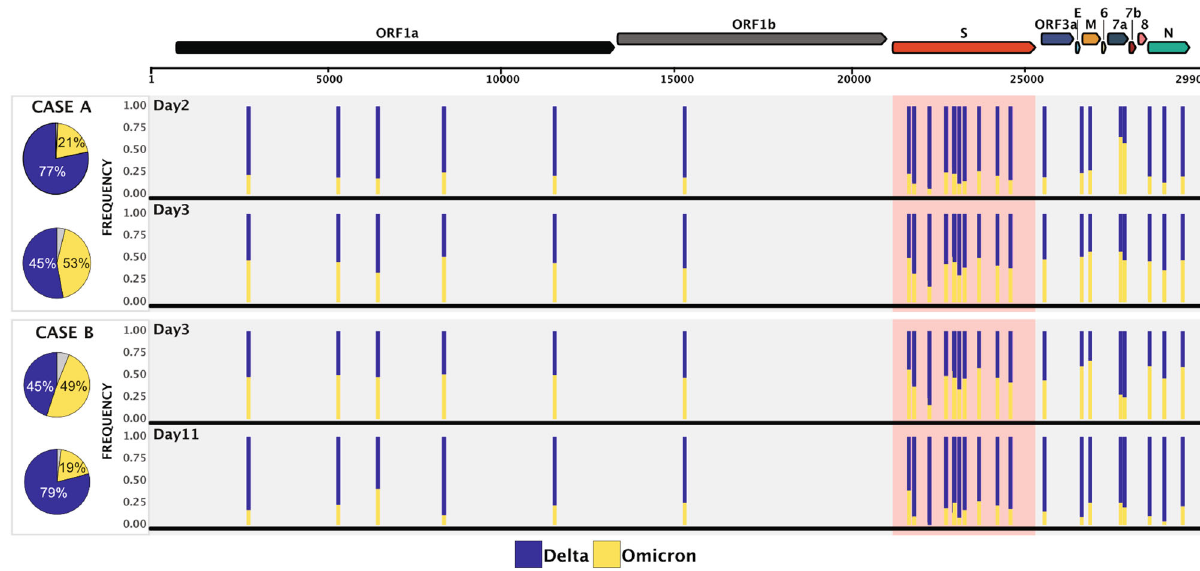
Fig. 2 Genome-wide view of the variant frequency of the SARS-CoV-2 Delta and Omicron lineage-de fi ning polymorphisms in specimens sequenced using the RVOP SARS-CoV-2 enrichment protocol. Pie graphs depict the average population frequency of Omicron and Delta lineage-de fi ning mutations in four clinical samples collected from Cases A and B. Segments in grey represent differences between the average read frequency of Omicron and Delta markers. A total of 27 polymorphisms de fi ning Delta and Omicron lineages are presented in relation to the annotated SARS-CoV-2 genome. The frequency of sequencing reads encoding each mutation is shown by histograms highlighting the constellation of mutations de fi ning each lineage. Blue bars demonstrate the frequency of mutations de fi ning the Delta lineage and yellow bars the Omicron lineage. Due to the close genomic location of lineage- de fi ning mutations in the spike region some bars are overlapping. Read frequencies shown were collected from RVOP data but were highly concordant between sequencing methods and